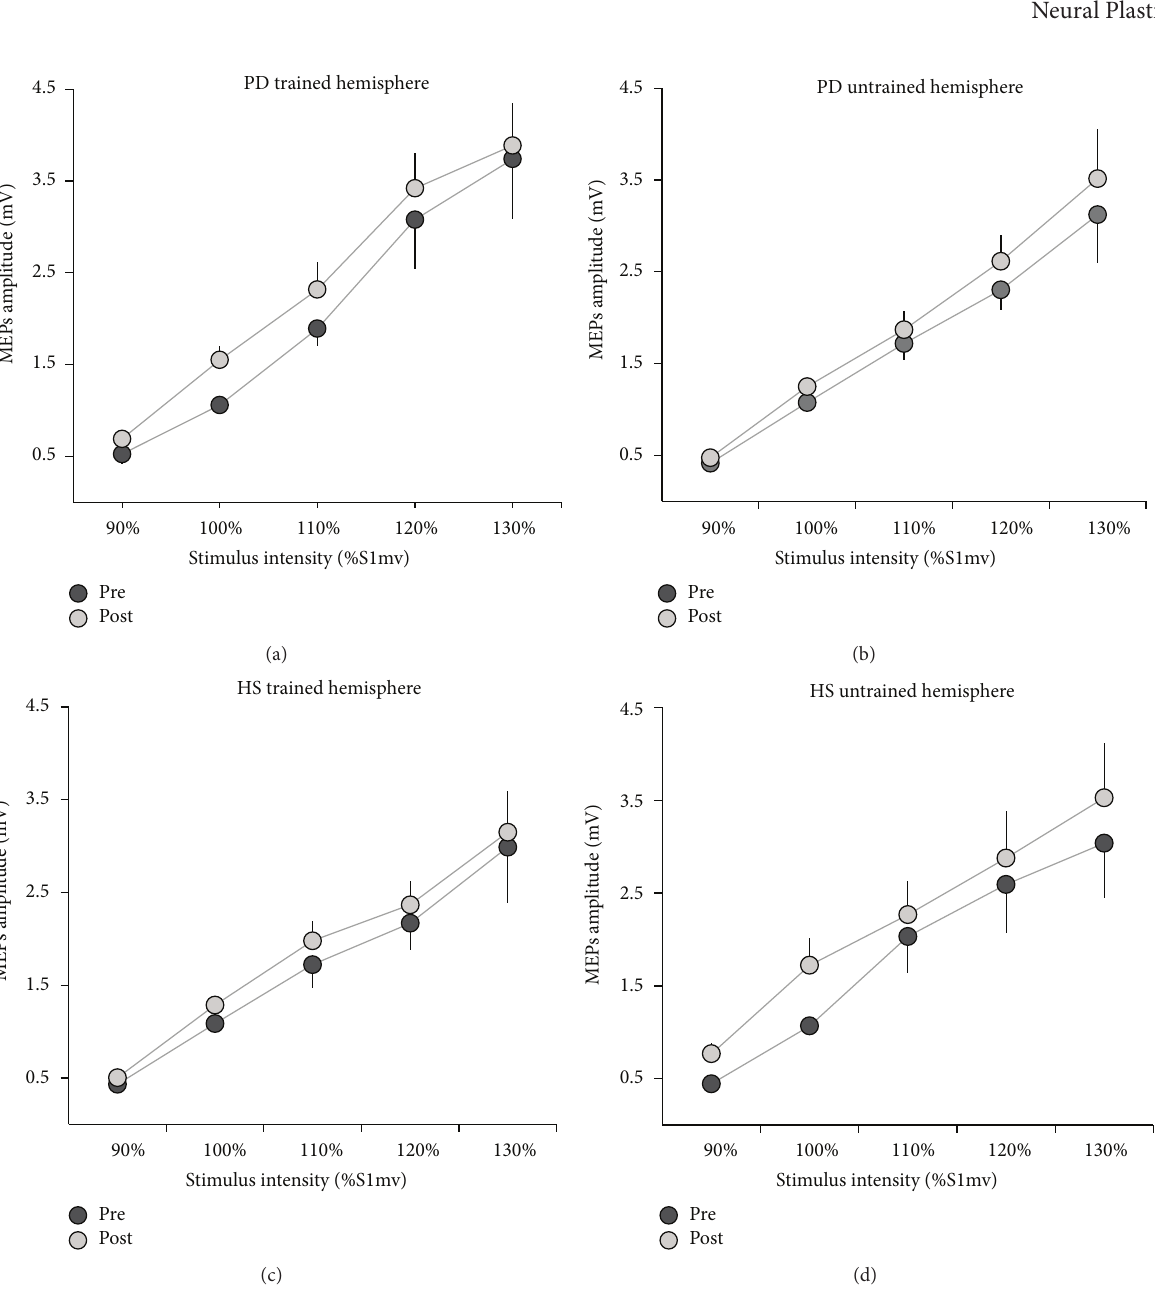
Figure 5: Input-Output (IO) curves measured in the first dorsal interosseus (FDI) muscle, of the trained (a and c) and the untrained (b and d) M1s before and after mirror visual feedback (MVF) training. Data of both groups, Parkinson’s disease (PD) patients (a and b) and healthy subjects (HS) (c and d), who underwent MVF training, are shown. MEP amplitudes, in mV, are depicted from 90% to 130% S1mV (the stimulus intensity needed to evoke MEPs of approximately 0.8 − 1 mV peak-to-peak amplitude). Vertical bars indicate standard error of the mean